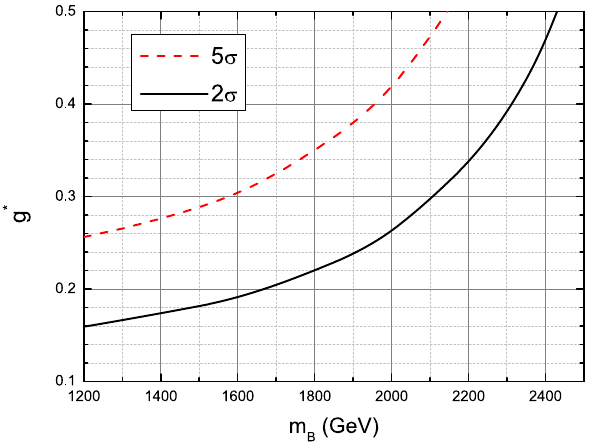
Fig. 6 Combined 2 σ exclusion limit and 5 σ discovery prospect con- tour plots for the signal in g ∗ − m B planes at CLIC with integral lumi- nosity 5 ab − 1